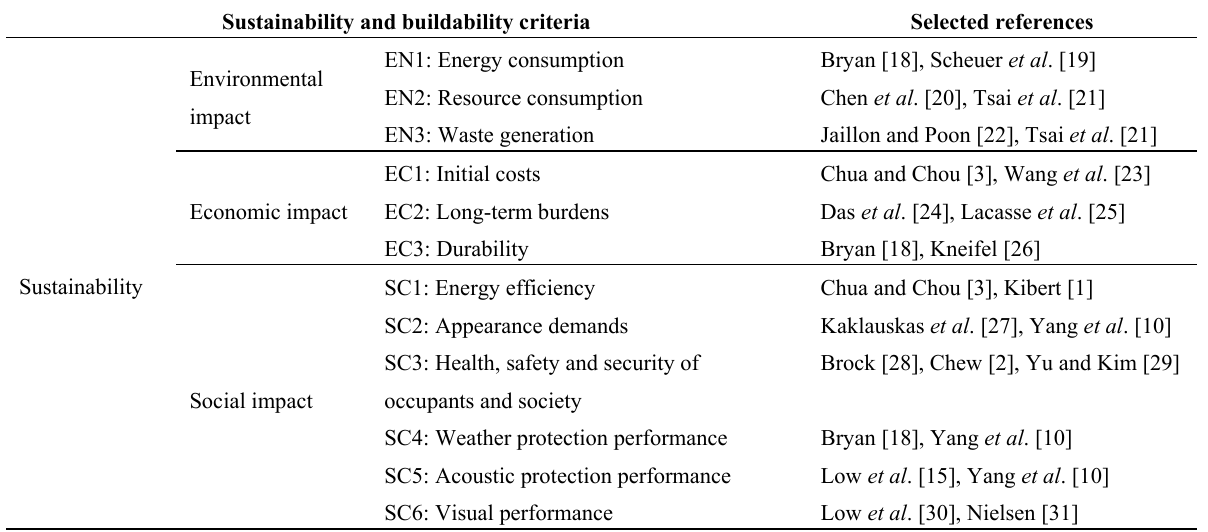
Table 1. Sustainability and buildability criteria for building envelope